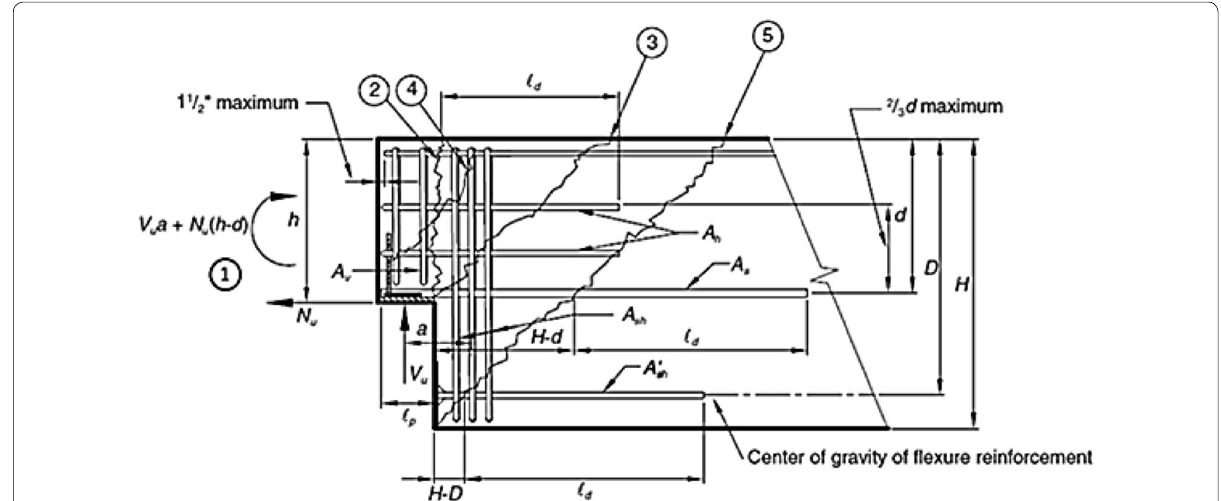
Fig. 1 Potential failure modes and steel reinforcements in dapped-end region (P. D. Handbook